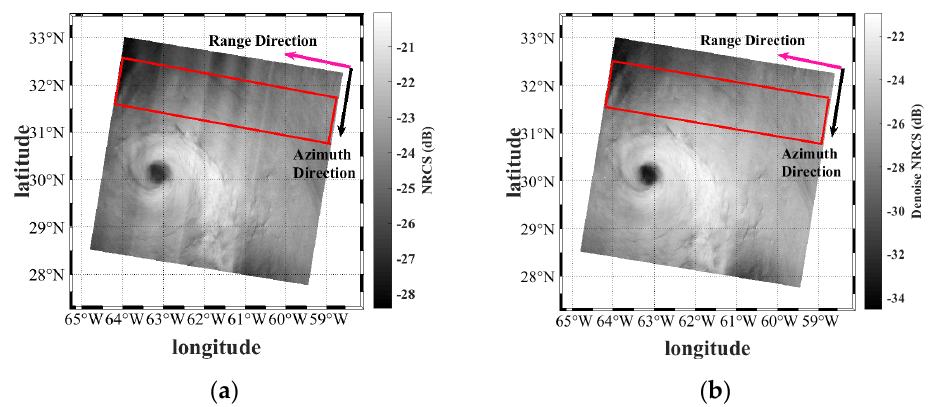
Figure 3. The RS-2 SAR image of TC Teddy on 2 September 2020, at 10:04:32 UTC. Red square denotes the selected sub-image. ( a ) The original SAR image, and ( b ) the SAR image after removing the influence of NESZ and strip splicing.